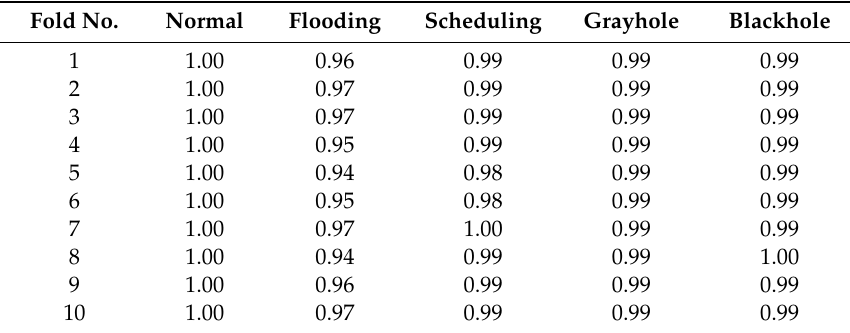
Table 4. Precision results of the 10 fold cross